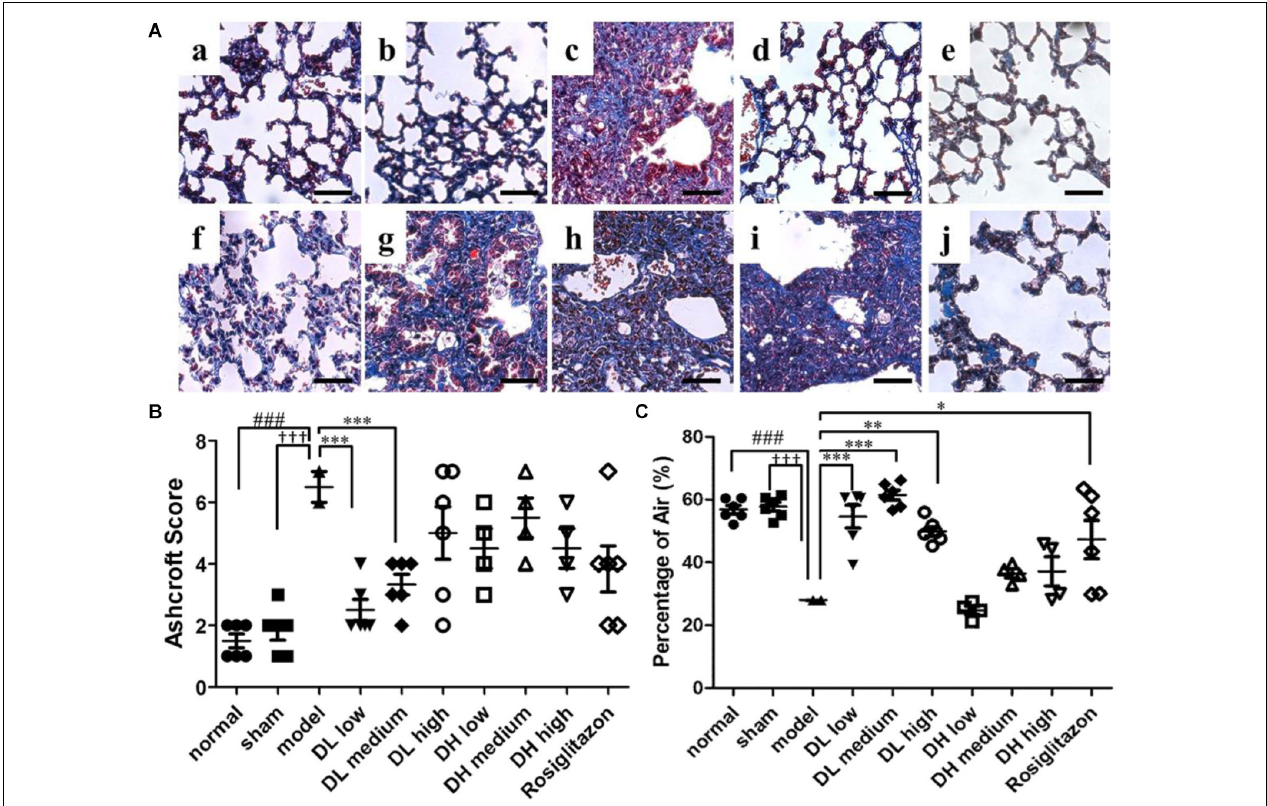
FIGURE 3 | Effects of DLP and DHP on pulmonary fibrosis in BLM-induced mice model. (A) Representative images of Masson’s trichrome staining results, scale bar = 50 µ m. Five micrometer sections of lung central area with different treatment were stained with Masson. a, normal; b, sham; c, model; d, DL low dose; e, DL medium dose; f, DL high dose; g, DH low dose; h, DH medium dose; i, DH high dose; j, ROS. (B) Comparison of the Ashcroft score among the experimental groups. (C) Comparison of the alveolar air area among the experimental groups. Results are expressed as the mean ± standard deviation. ### P < 0.001 versus the normal group; ††† P < 0.001 versus the sham group; ∗∗∗ P < 0.001, ∗∗ P < 0.01 and ∗ P < 0.05 versus the model group.